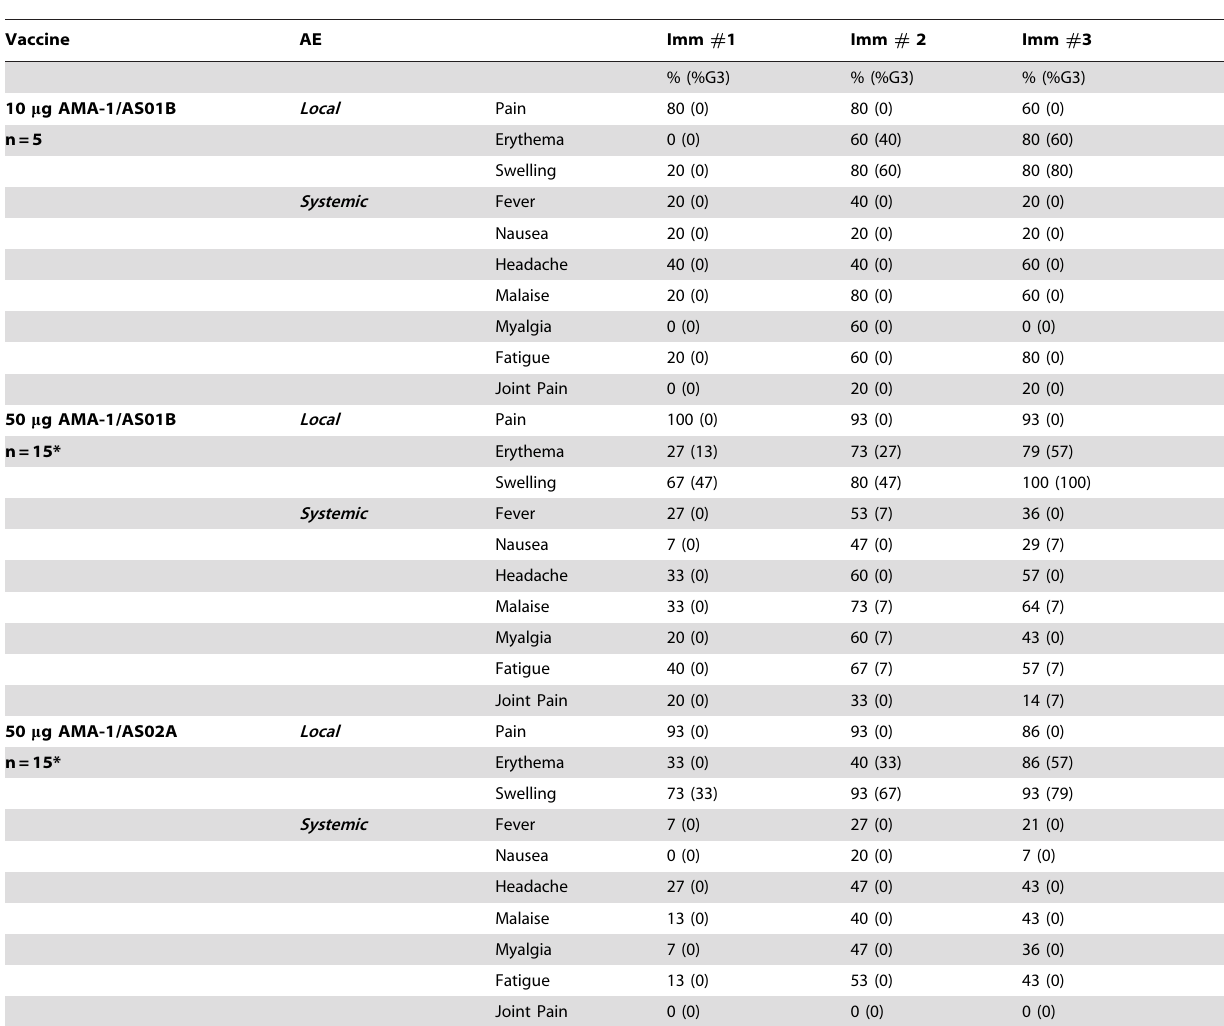
Table 2. Local and systemic solicited adverse events (AEs) Day 0 through Day 7.